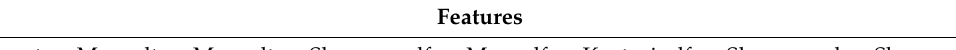
Table 4. The features of feature